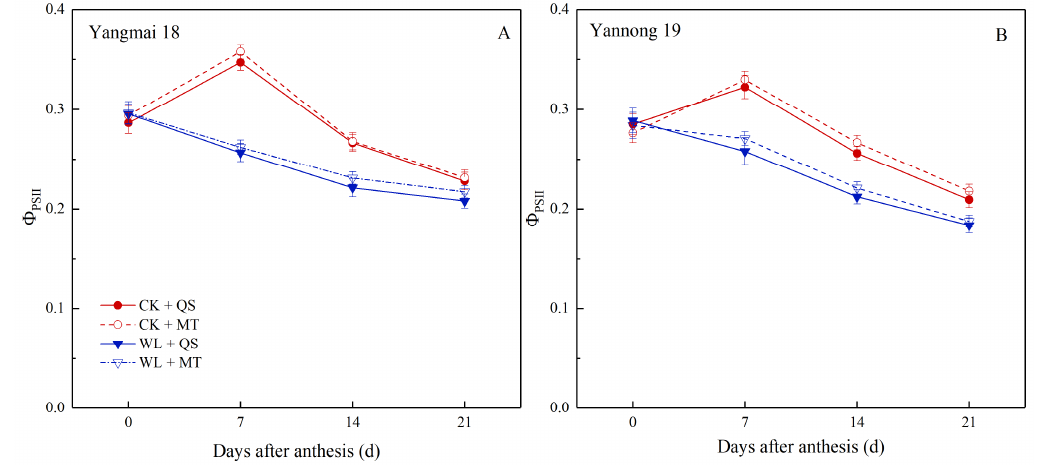
Figure 9. Post-flowering changes in flag leaf actual photochemical efficiency of Yangmai 18 ( A ) and Yannong 19 ( B ) under different treatments, i.e., CK + QS: leaf spraying with distilled water under non-waterlogged conditions; CK + MT: leaf spraying with 100 μmol·L −1 of melatonin under non-waterlogged conditions; WL + QS: leaf spraying with distilled water under waterlogged conditions; WL + MT: leaf spraying with 100 μmol·L −1 of melatonin under waterlogged conditions.